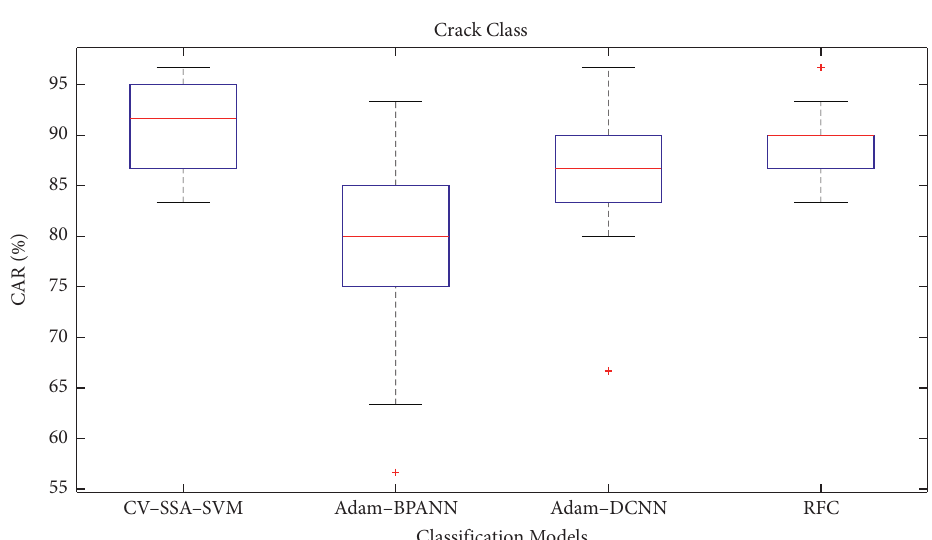
Figure 15: Box plot of classification accuracy for the “crack”